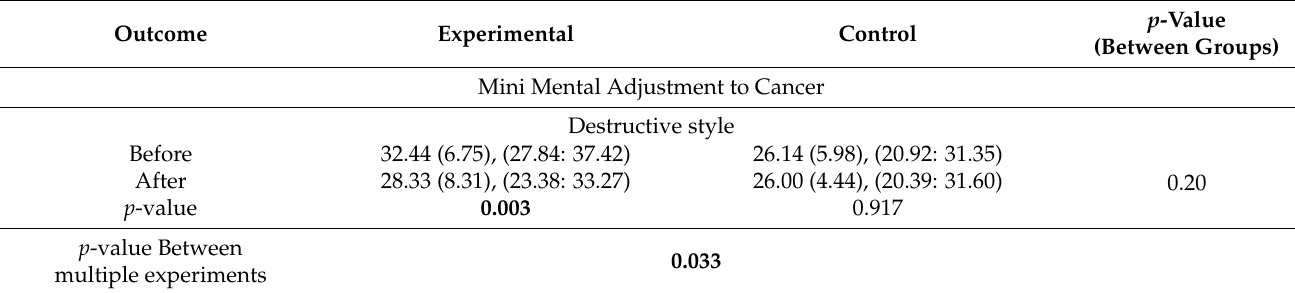
Table 2. Primary outcomes—the pre-post comparison of results as well as between groups comparison and the calculation of multiple experiments effect for all the measured outcomes.